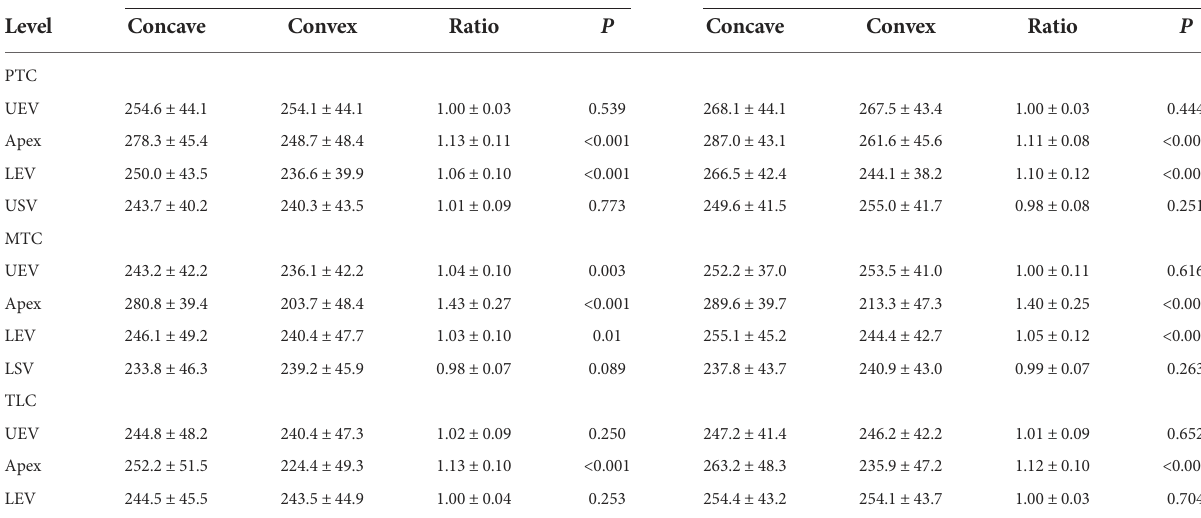
TABLE 4 HU values and the asymmetric ratio at UEV, Apex, and LEV of major and minor